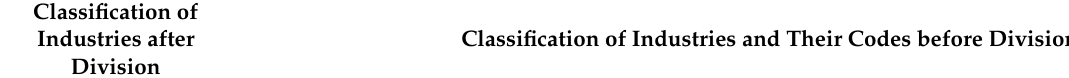
Table 1. The industry classification of industrial land.